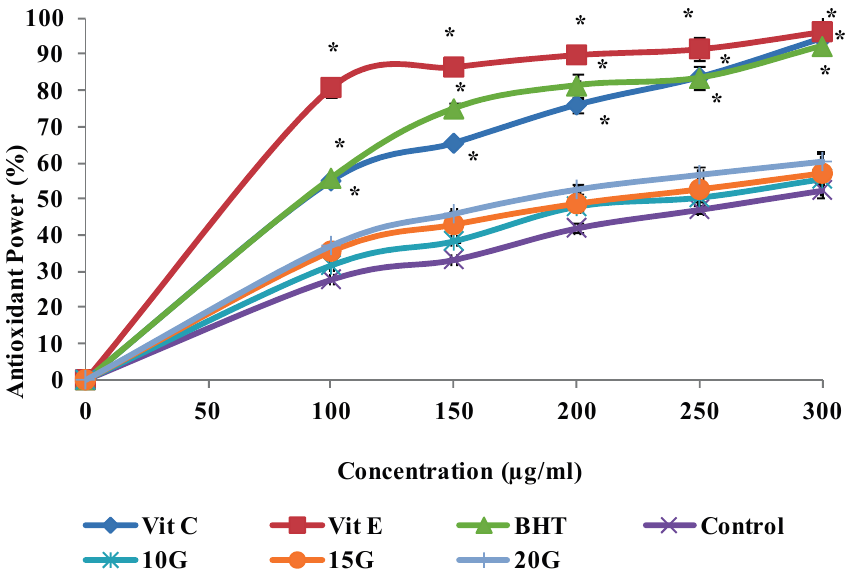
Figure 3. Effect of gamma irradiation on the ferric reduction antioxidant power activity of methanolic extracts and standards at different concentrations. Values are means ± SE. Each value represents the mean of three replications. * Significance different from Control group at the same concentration. Significance was determined at p < 0.05.